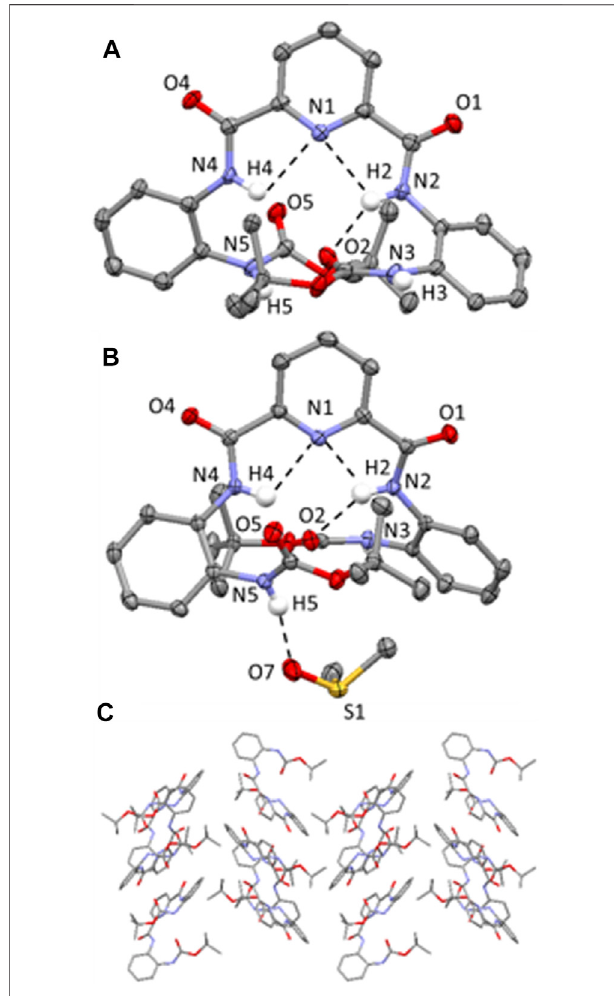
FIGURE 3 | (A) Molecular structure of compound 2 ; (B) Molecular structure of compound 2 -DMSO. H atoms (expect those on the N atoms of theamidebonds)havebeenomittedforclarityanddisplacementellipsoidsare at 50% probability level. H atoms are shown in white, C in grey, N in light blue and C inred.Hydrogen-bondinginteractionsare shown asdashed black lines; (C) Crystal packing of 2 highlighting the herringbone stacking arrangement aligned along the b axis. Hydrogen atoms have been omitted for